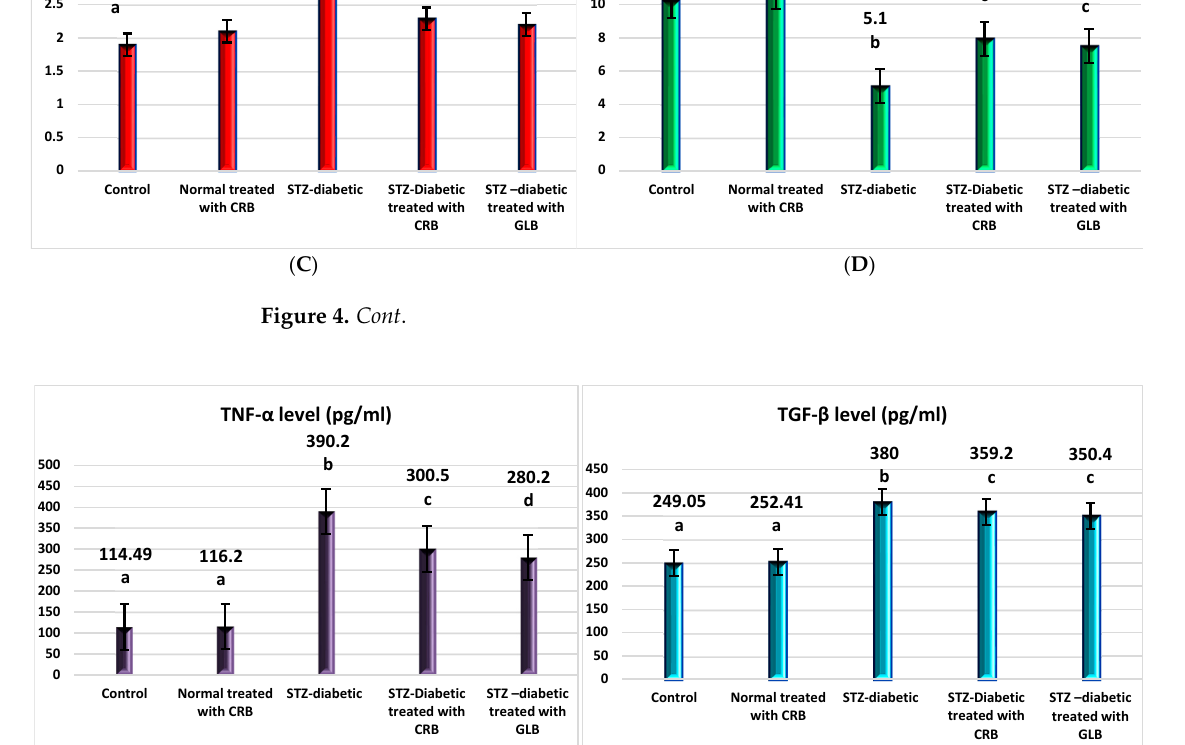
Figure 4. Effect of n-butanol fraction of Colvillea racemosa total extract (CRB) oral administration on inflammatory markers in Streptozotocin (STZ)-induced diabetic rats: VCAM level ( a ), ICAM-1 level ( b ), IL1- β level ( c ), paraoxonase activity ( d ), TNF- α level ( e ), and TGF- β level ( f ). Results are displayed as means ± S.D. (measured in triplicate; n = 3). Means with different letters are significantly different ( p < 0.05).